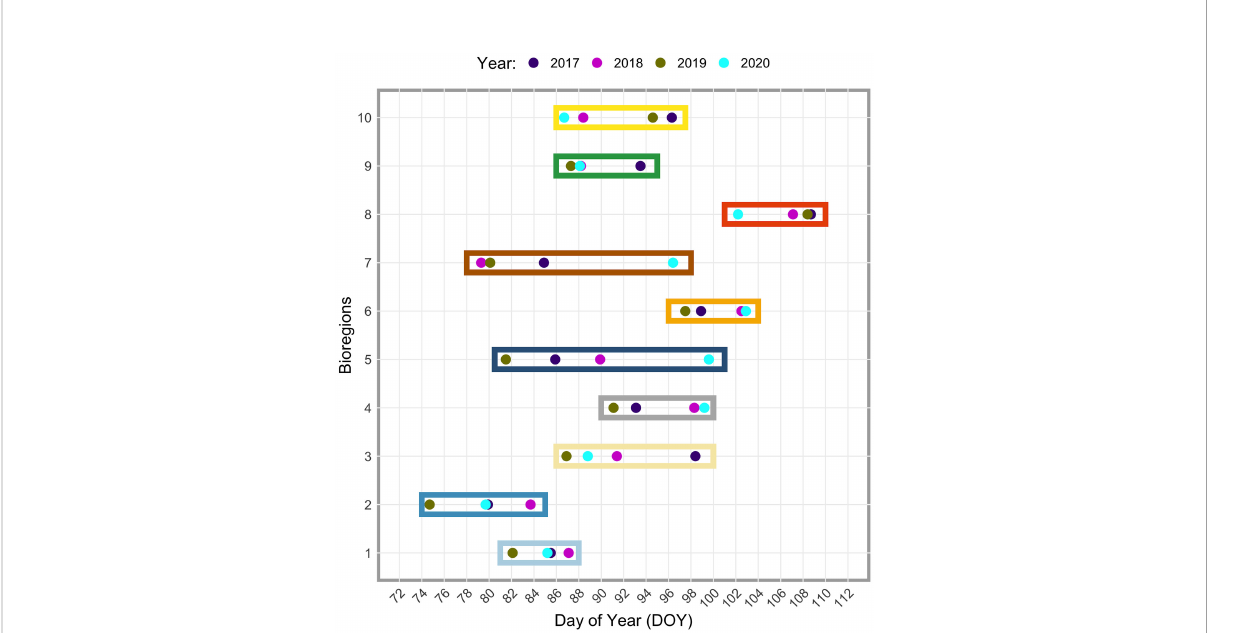
FIGURE 10 Inter-annual (2017-2020) differences in spring bloom onset date among the ten bioregions. Different years are indicated with different colored dots (see the top of the fi gure). The colored dots are grouped within a box corresponding to a speci fi c bioregion (y-axis). Note that each color used for the boxes corresponds to that used in Figure 5 and identi fi es the same bioregion. The day of the year (DOY) is reported on the x-axis. See also Table S1 in the supplementary material.